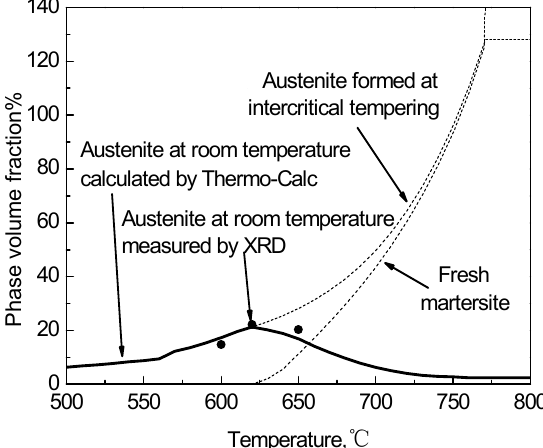
Figure 9. Phase volume fraction calculated by Thermo-Calc and measured by XRD. The RA content calculated by the model is basically consistent with the XRD meas- ured value, which can be used to estimate the relationship between the TT and the RA content, being conducive to the optimization of the heat treatment process [26]. When the TT is lower than 620 °C, almost all of the RA remains at room temperature, forming met- astable retained austenite. In this temperature range, the higher the content of alloying elements in RA is, and the higher the stability is. When the TT is higher than 620 °C, part of the RA transforms into fresh martensite during oil cooling, which reduces the RA con- tent. Figure 10 shows that Thermo-Calc calculates the changes in the mass fraction of each component in the austenite phase varying with temperature in the equilibrium state. As the TT increases, the content of austenite stabilizing elements containing carbon, manga- nese and nickel in the austenite phase gradually decreases so that the chemical stability decreases [27].